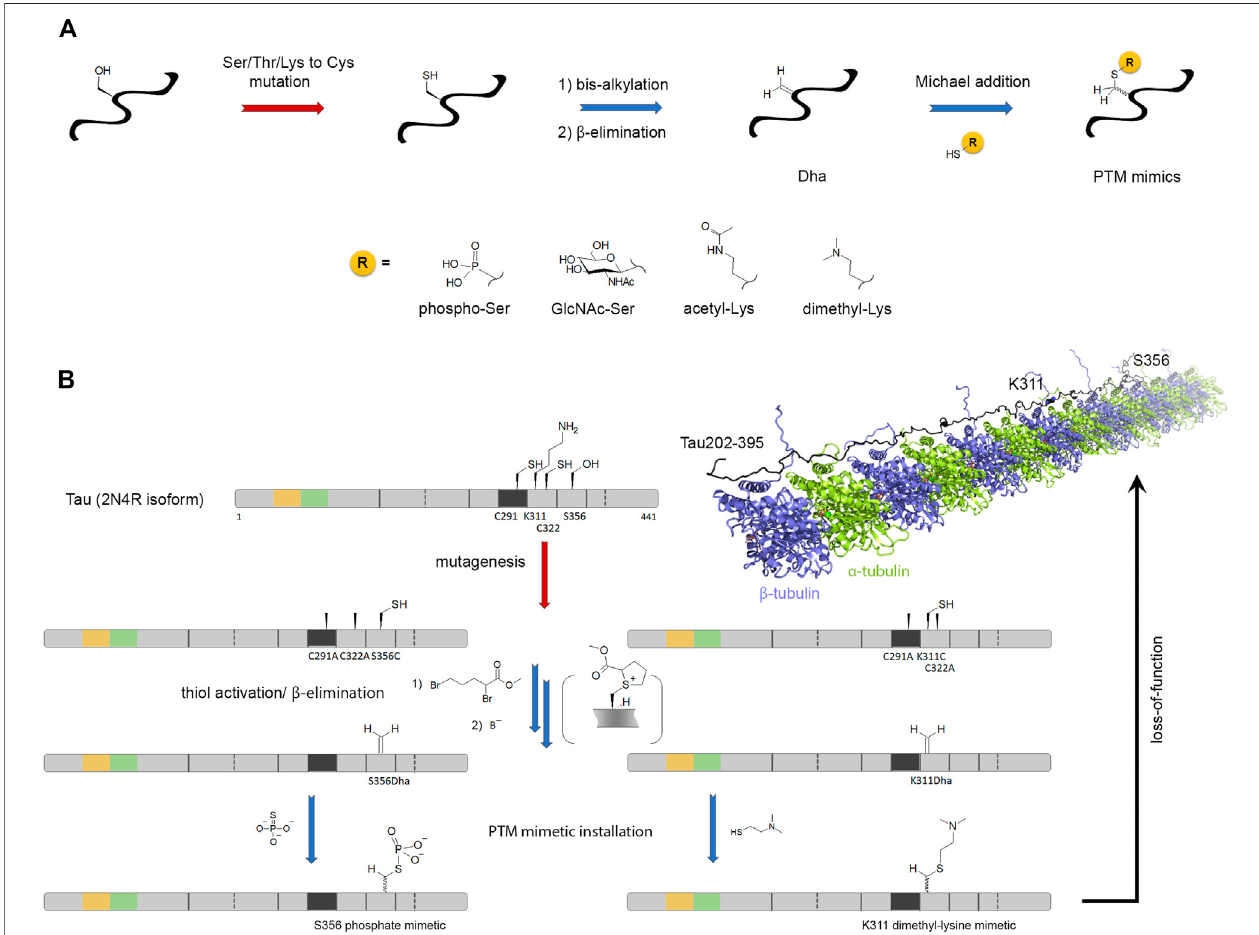
FIGURE6| Posttranslationalchemicalmutagenesis. (A) GeneralschemeoftheposttranslationalchemicalmutagenesisapproachforincorporationofPTMmimics byMichaeladdition ofPTM-thiolderivatives ondehydroalanine(Dha)alkene function. Thelatter isobtained fromserine/threonine/lysine-to-cysteinemutationat thePTM site and β -elimination of the bis-alkylated thiol function of cysteine. Addition of thiophosphate, S-GlcNAc, N-acetylcysteamine and captamine generates mimetics of phosphorylation, O-GlcNAcylation, N-acetylation and N,N-dimethylation, respectively. The thio-ether bond formation leadsto aracemizationofamino acidC α . (B) This approach is illustrated by S356 phosphorylation and K311 acetylation in tau protein for the investigation of the PTM effect on loss-of-function in microtubule polymerization (PDB ID: 7PQP) (Brotzakis et al., 2021; Lindstedt et al., 2021). Chemical reactions are indicated by blue arrows and enzymatic reactions by red arrows.